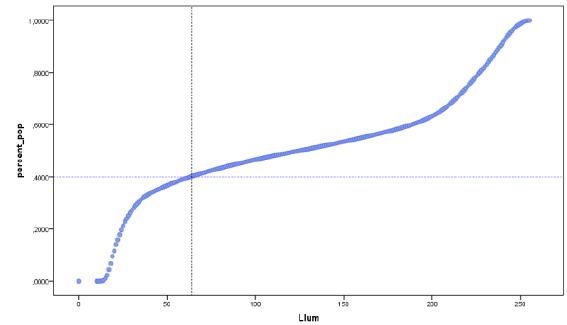
Figure 8. Night light intensity vs. cumulative population